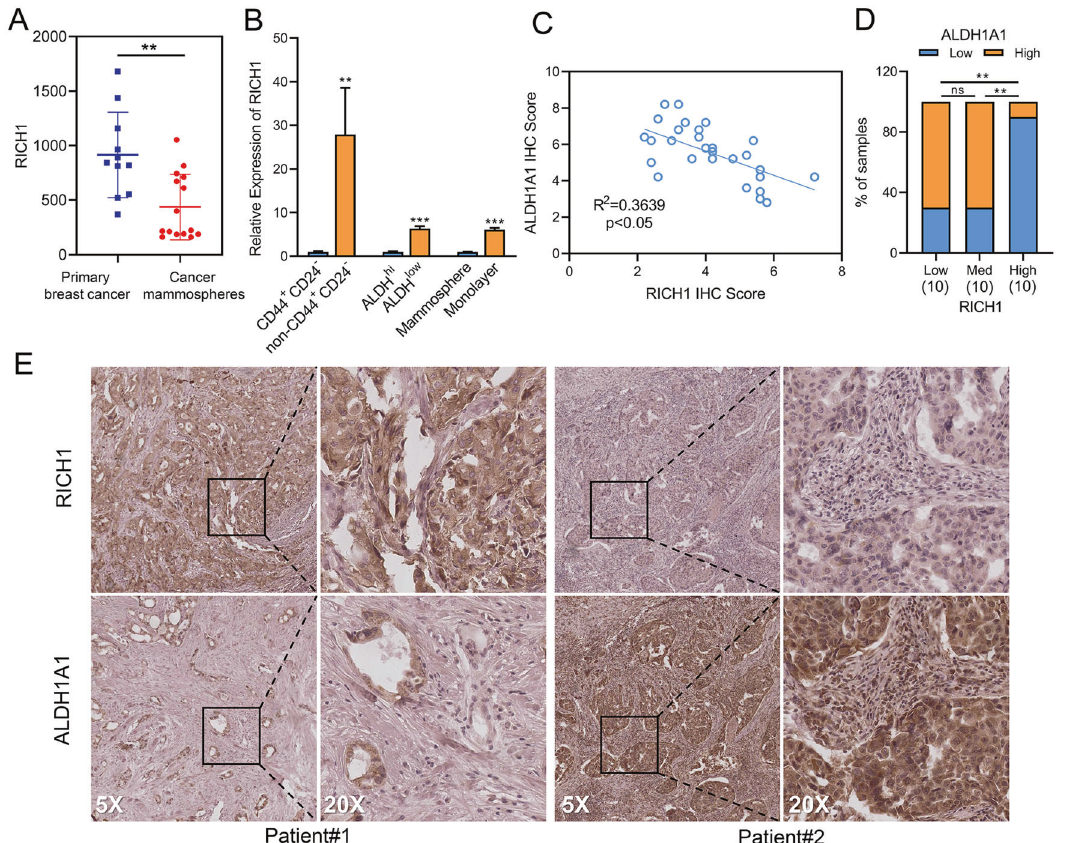
Fig. 2 Low expression of RICH1 is associated with the enhancement of CSC properties in breast cancer. A RICH1 expression in primary bulk tumor samples and mammospheres provided by GSE7515. B RICH1 mRNA expression levels in BCSC-like subpopulations (CD44 + CD24 − , ALDH hi and mammospheres) and non-BCSC-like subpopulations (non-CD44 + CD24 − , ALDH low and adherent monolayer). C Correlation analysis between RICH1 and ALDH1A1 intensities in 30 breast cancer samples. D ALDH1A1 expression levels in breast cancer samples with different RICH1 expression. E Representative IHC images of RICH1 and ALDH1A1 of 2 breast cancer patients, PATIENT#1 (case number of #1525760) and PATIENT#2 (case number of #1392301). Among them, PATIENT#1 represented an example with high expression of RICH1 and low expression of ALDH1A1, while PATIENT#2 represented another example with low expression of RICH1 and high expression of ALDH1A1. Data represent mean ± SD. Statistical signi fi cance was determined by two-tailed unpaired t -test ( A , B ), pearson ’ s r ( C ) or chi-squared test ( D ). Abbreviation: CSC cancer stem cell, BCSC breast cancer stem cell, ns not signi fi cant; * p < 0.05; ** p < 0.01; *** p <